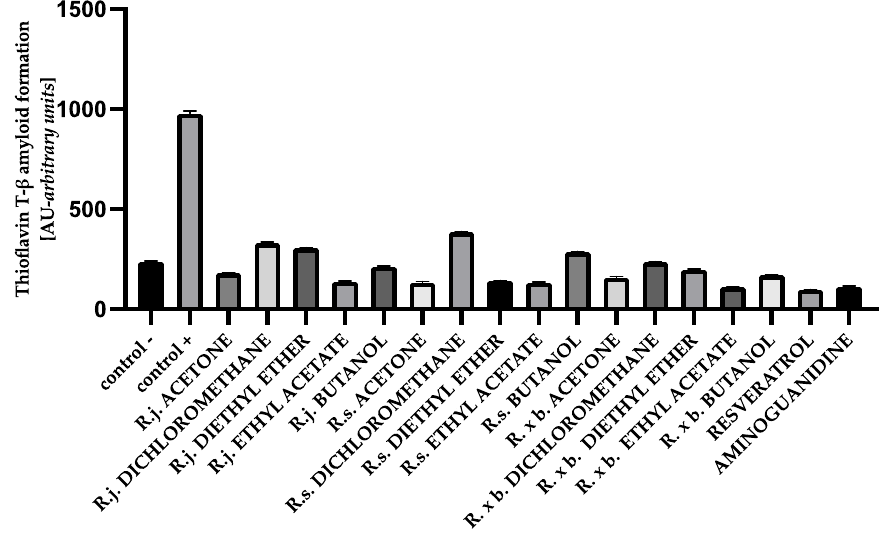
Figure 10. The effect of extracts and fractions on the in vitro formation of amyloid- β products—thioflavin T in BSA glycation. R.j., R.s., and R. × b. mean Reynoutria japonica , Reynoutria sachalinensis , and Reynoutria × bohemica , respectively. Error bars shown in this figure are means ± SD for n ≥ 5. All results were statistically significant at p ≤ 0.0001 compared to control +. Detailed information can be found in the Supplementary Material.